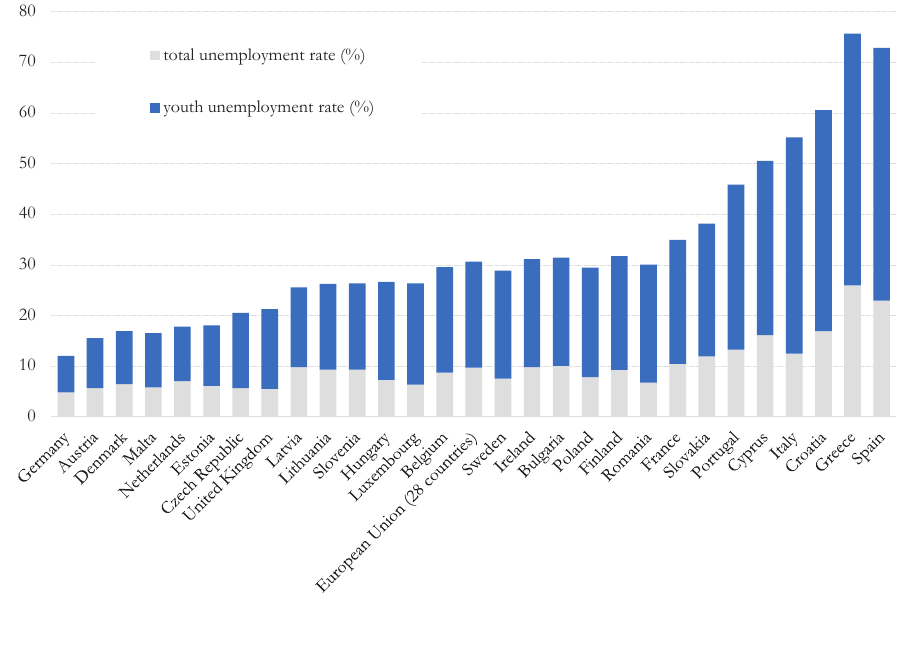
Fig. 1 – The unemployment rate in 28 States of the EU, the month of March 2015. Source: Eurostat,